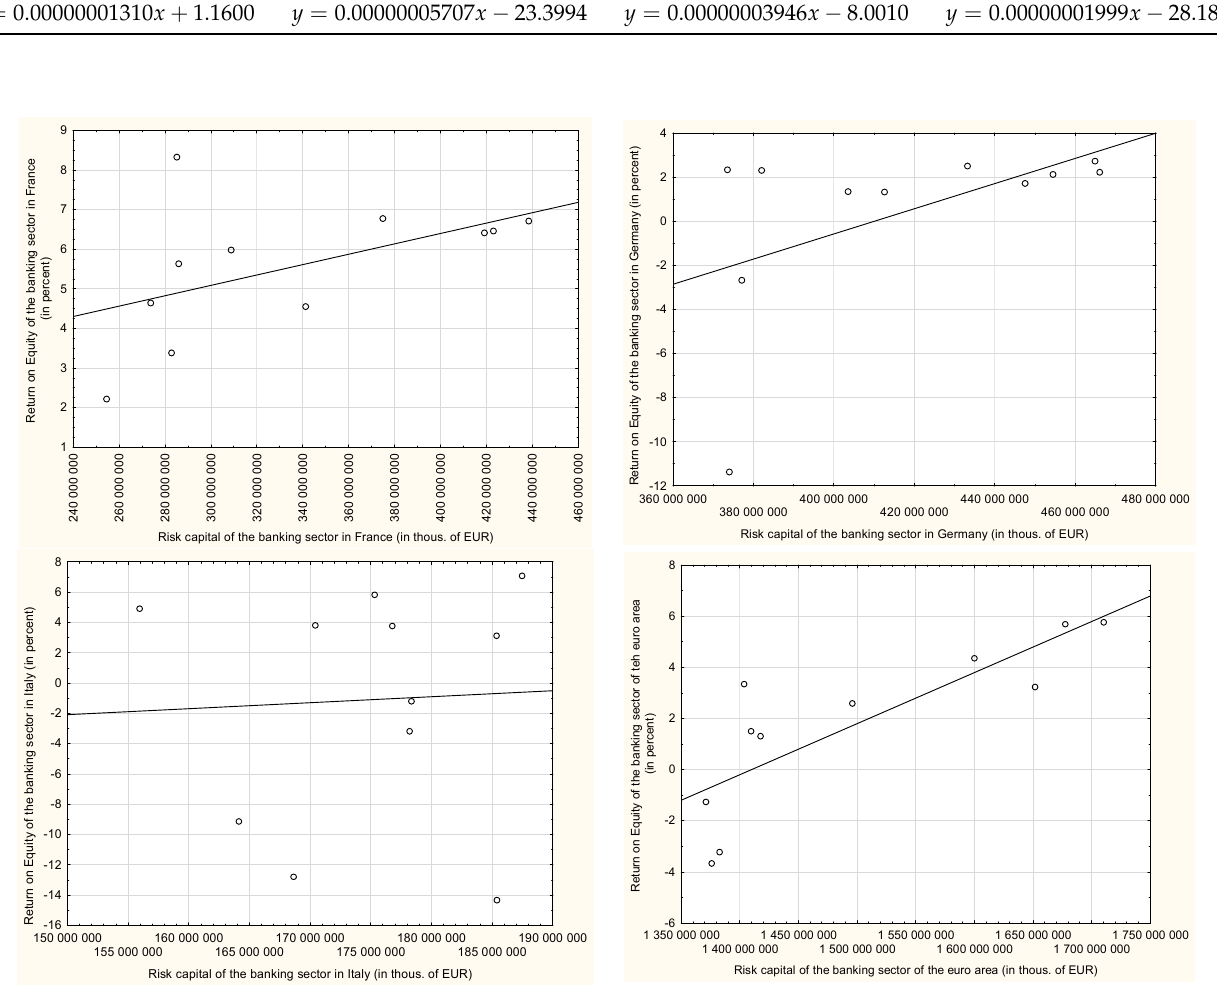
Figure 5. Two-dimensional scatterplots of stage 2 (source: own work).